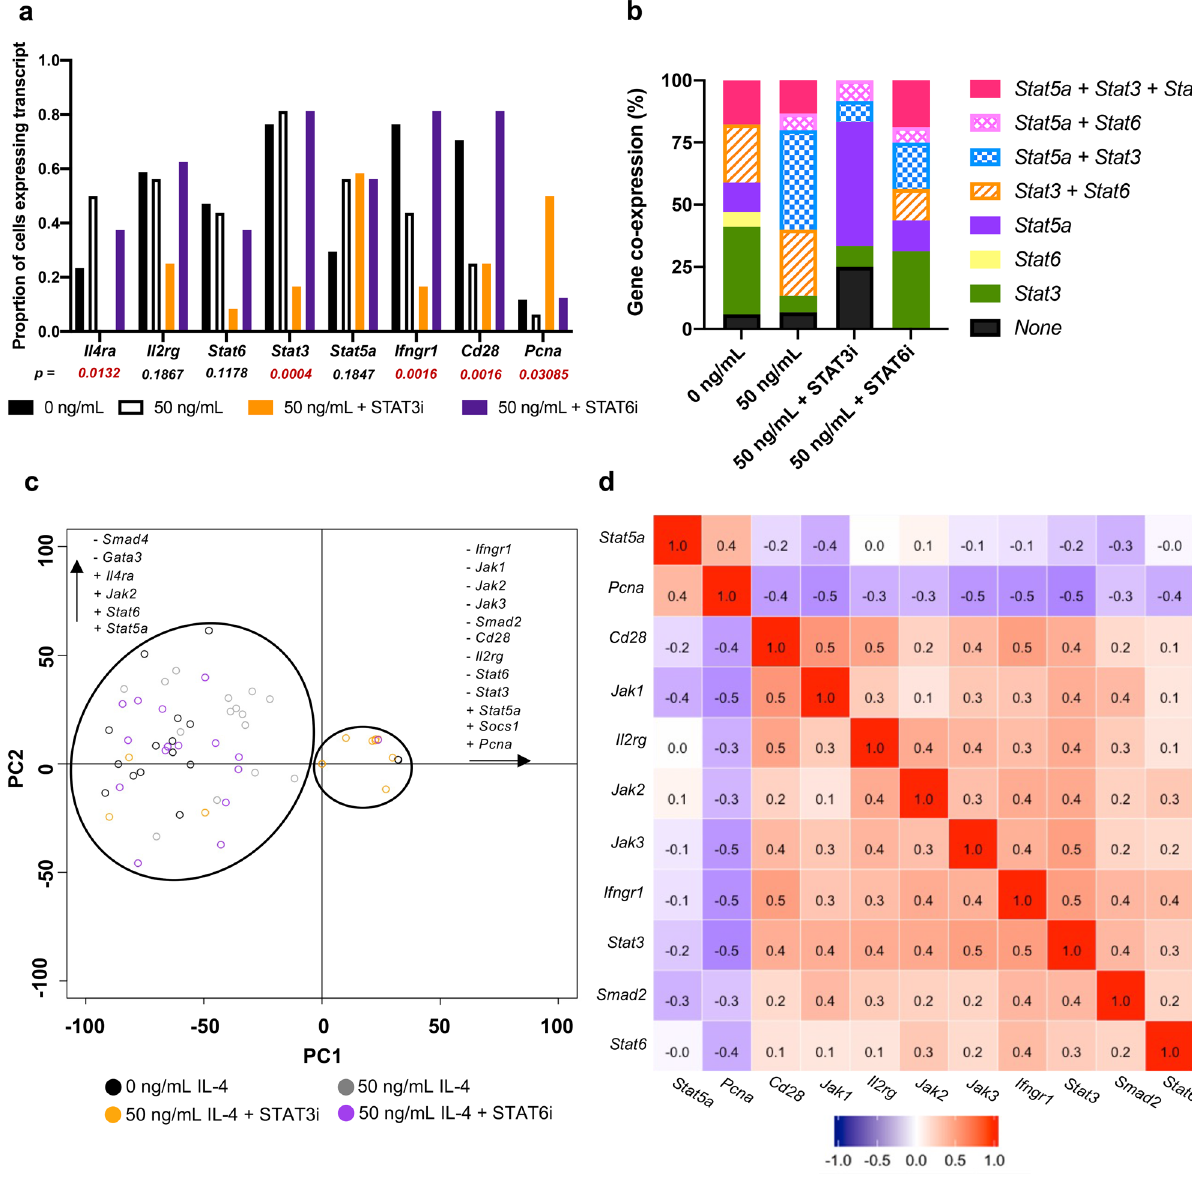
STAT3/STAT6 inhibition completely abolished IL-4-inducible IL-4R ⍺ activity. STAT3 inhibition also prevented IL-4-induced STAT6 phosphorylation, suggesting a novel receptor-mediated inter-regulatory relationship between the two transcription factors. Furthermore, inhibition of STAT3 down-regulated Ilr4a , Il2rg , Jak1 , Jak2 , Stat3 and Stat6 gene expression in IL-4R ⍺ + CD4 T cells, indicating that STAT3 broadly regulated genes associated with IL-4/IL-13 signalling. Intriguingly, the engagement of STAT3 was found only under high IL-4 concentrations (at least 10 ng/mL), unlike STAT6 (1 ng/mL). This was consistent with both (1) the existing IL-4